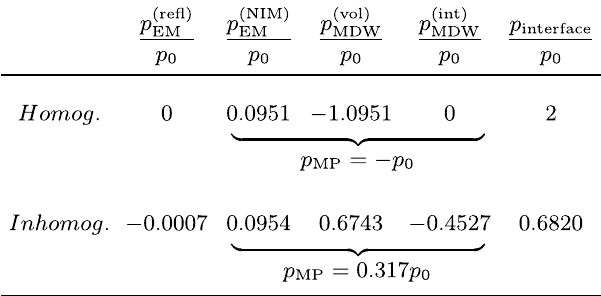
( refl ) p ( NIM ) EM ), EM field in NIM ( EM ), atomic MDW volume